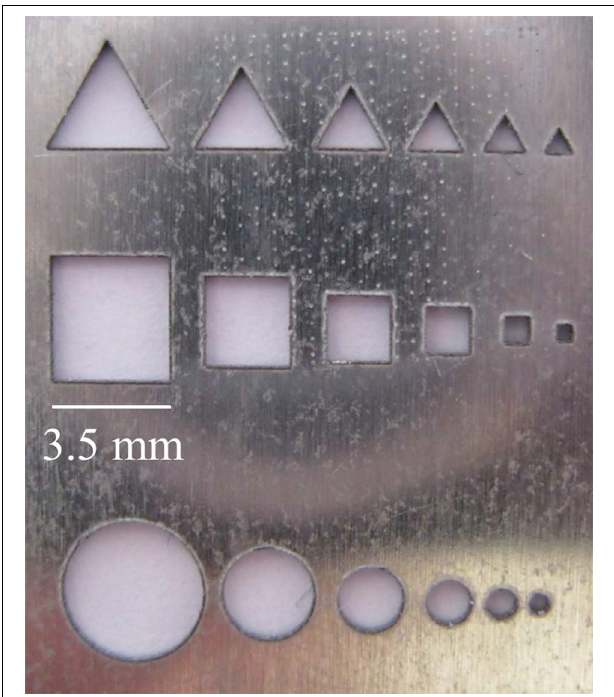
FIGURE 9 | Example of through-cutting of 0.3mm thick aluminum sheet using 60ns pulses (1064nm) delivered via the NCF [50].